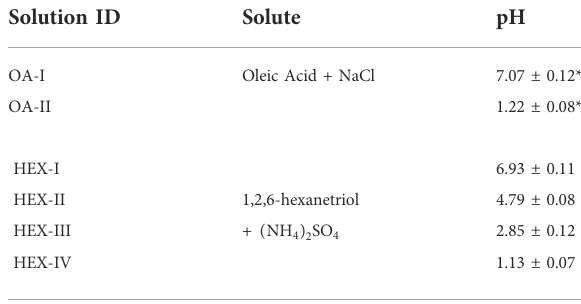
TABLE1Informationofthemothersolutionsusedtogenerateaerosol